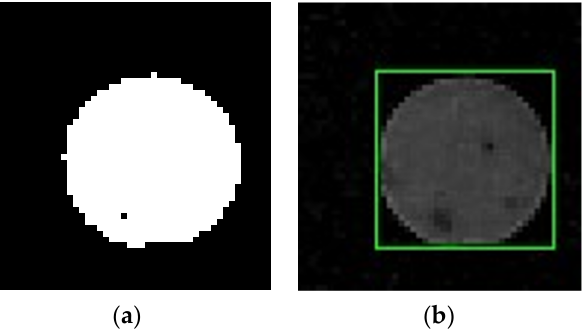
Figure 5. Generation of the Si image by binarization (P0, Acc = 1, Exp: 10,000 μ sec, image size 48 × 49 px): ( a ) Binarized image of differential absorption image; ( b ) Boundary rectangle of the extracted Si image superimposed on the original differential image.